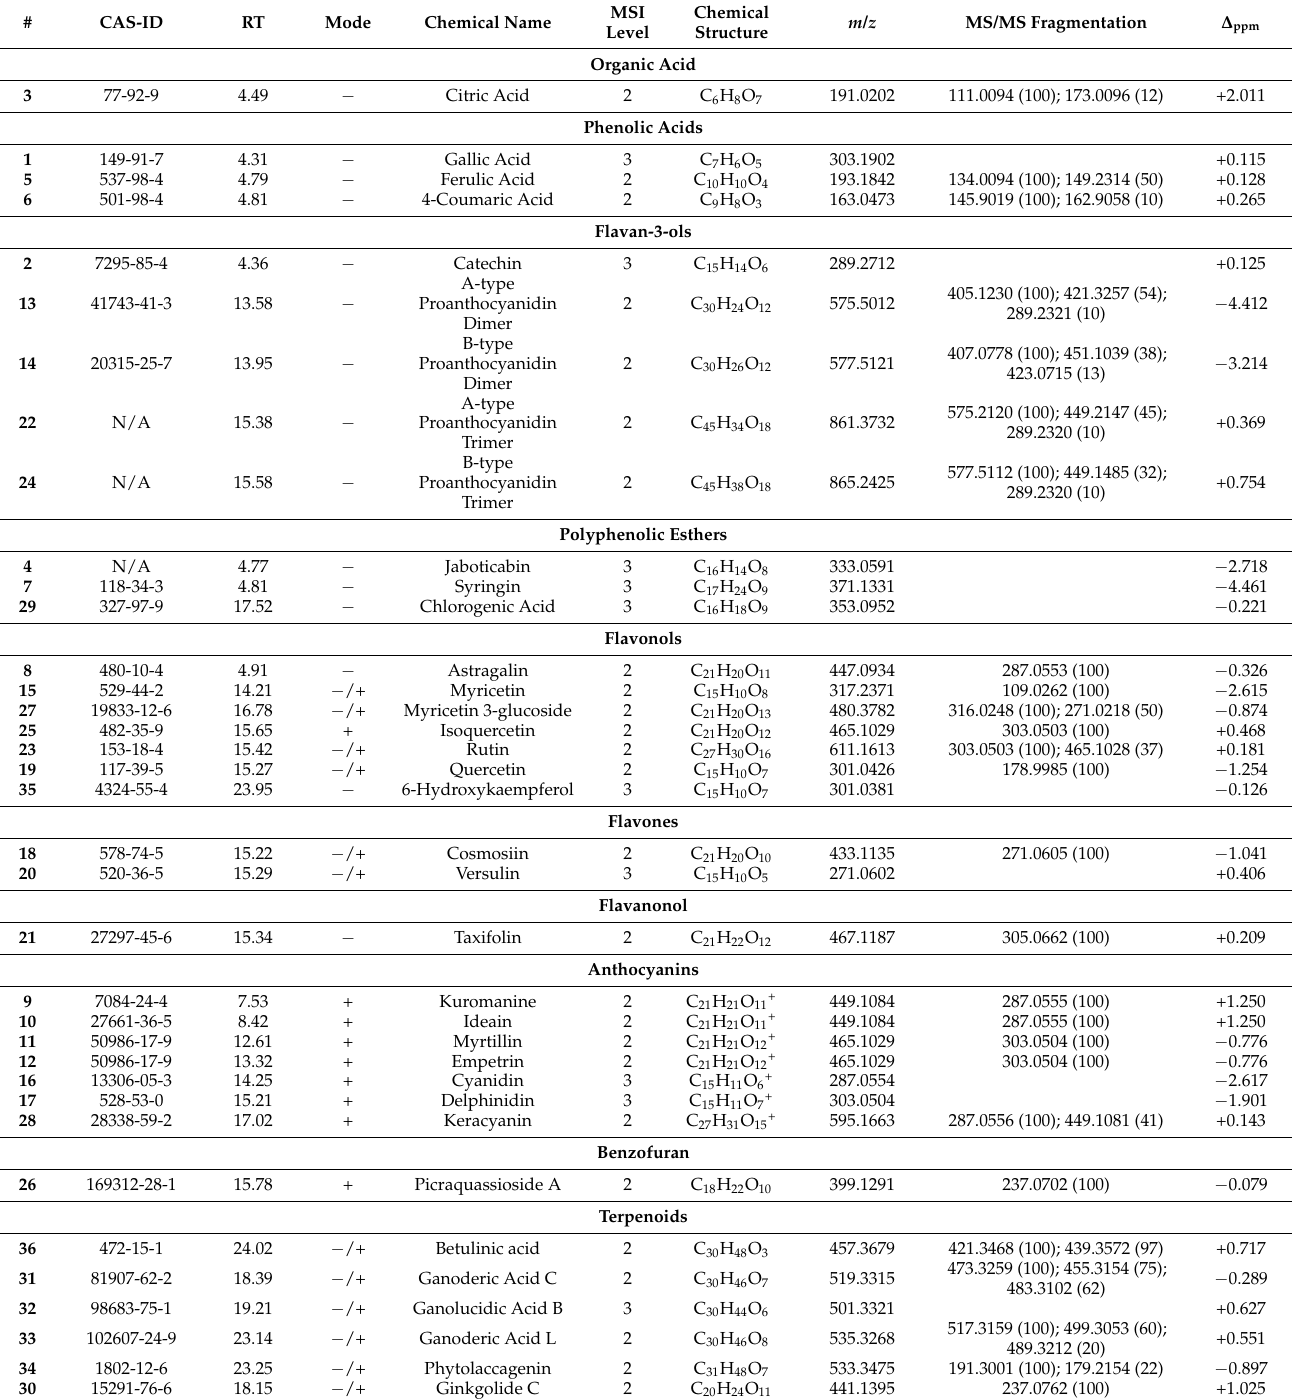
Table 3. Bioactive compounds annotated in Eugenia involucrata fruit extract. The columns report CAS-ID, retention time (RT), mode of analysis ( − /+), name and structural formula, MSI annotation level, charged molecular weight ( m/z ), observed mass fragmentation, and mass accuracy shift in ppm ( ∆